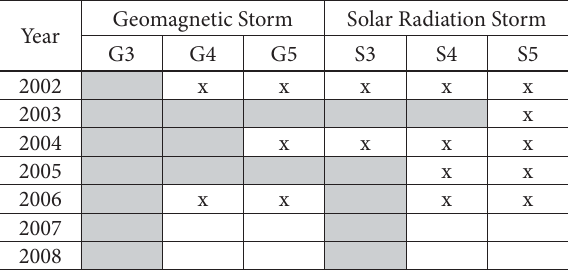
Table 1. Overview Geomagnetic and Solar